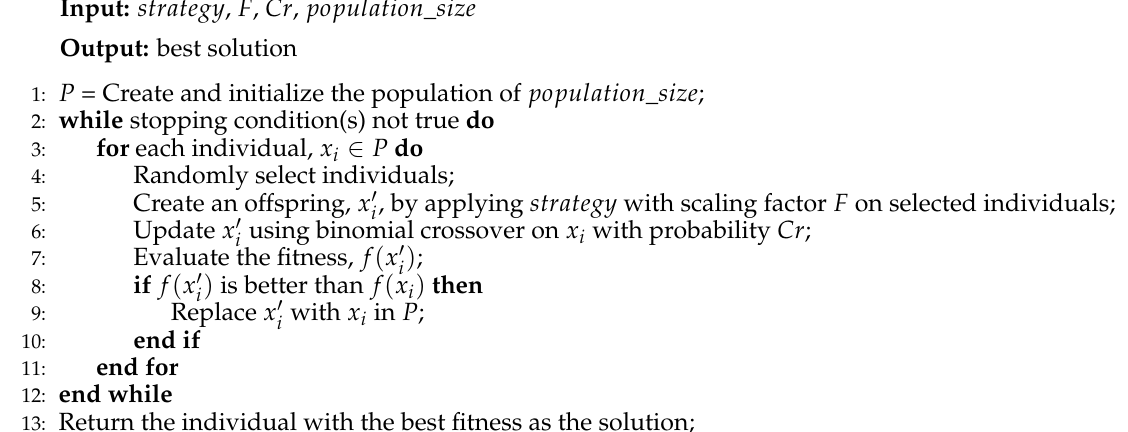
Algorithm 2 Differential Evolution